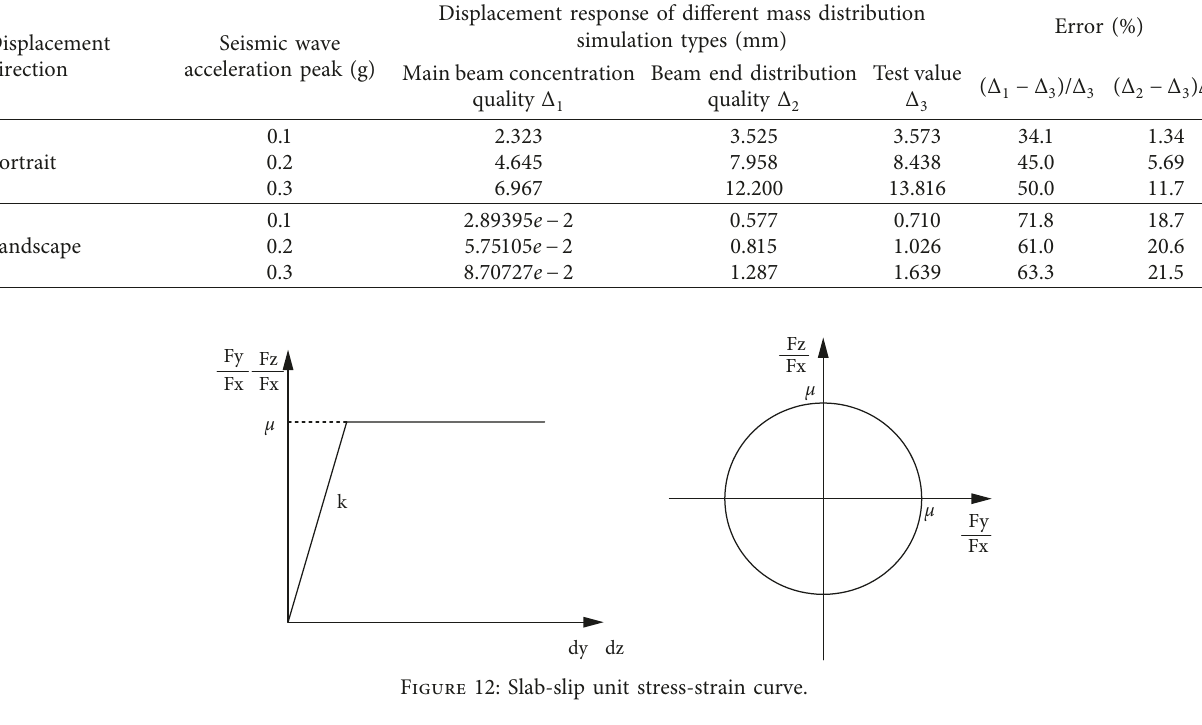
Table 5: Main beam displacement response result.